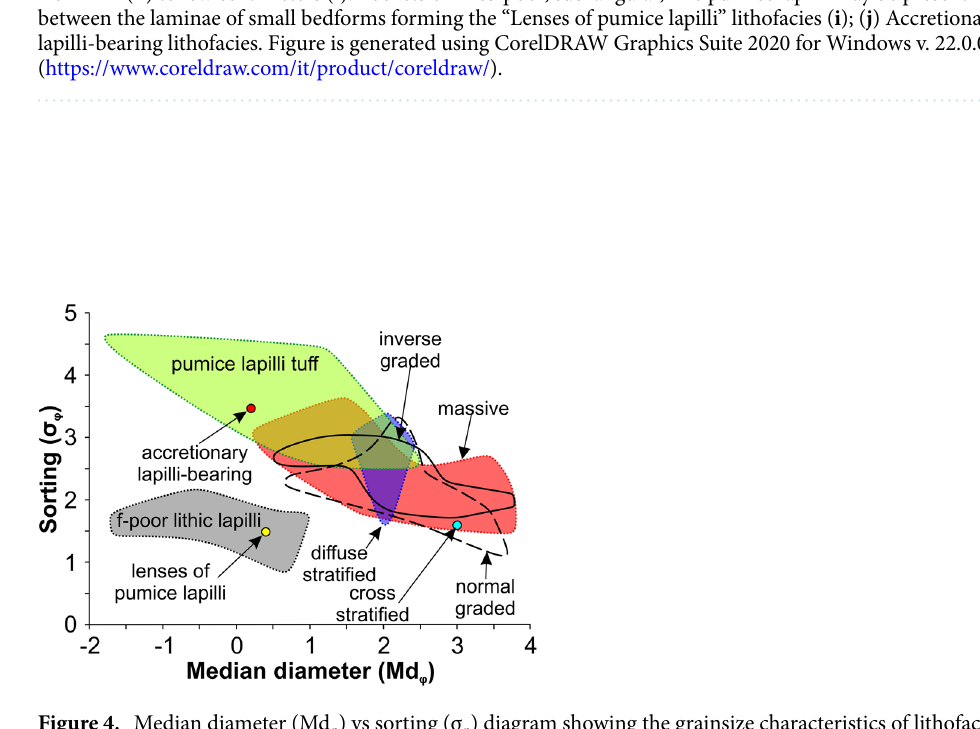
Figure 4. Median diameter (Md φ ) vs sorting (σ φ ) diagram showing the grainsize characteristics of lithofacies recognized in the medial pyroclastic current deposits of the Campanian Ignimbrite eruption. Figure is generated using CorelDRAW Graphics Suite 2020 for Windows v. 22.0.0.412 (https ://www.corel draw.com/it/produ ct/corel